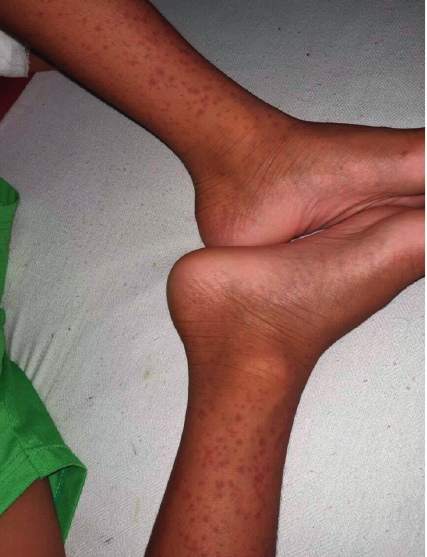
Figure 2: A photograph demonstrating classical nonblanching and a palpable purpuric rash over extensor surface of